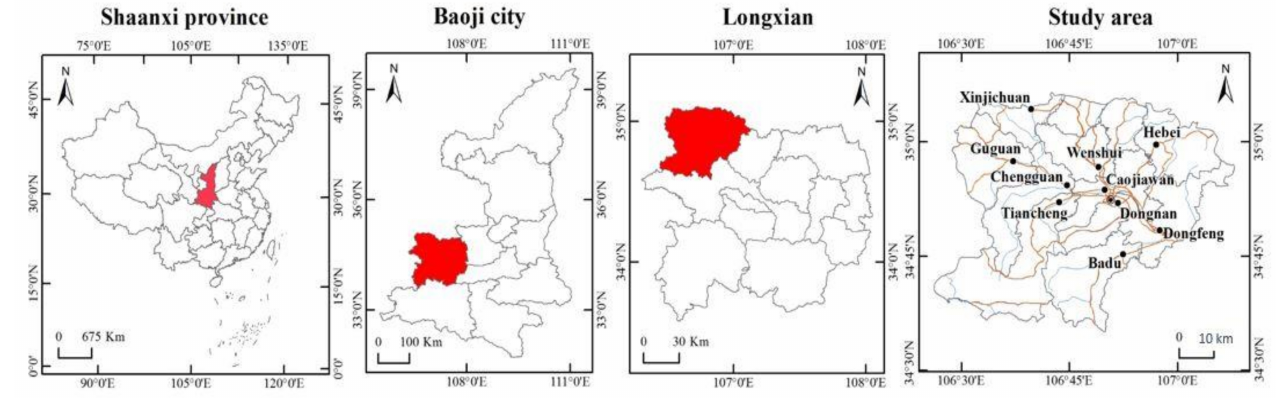
Figure 1. Study area covering the Longxian (Long) County, Baoji City, Shaanxi Province,